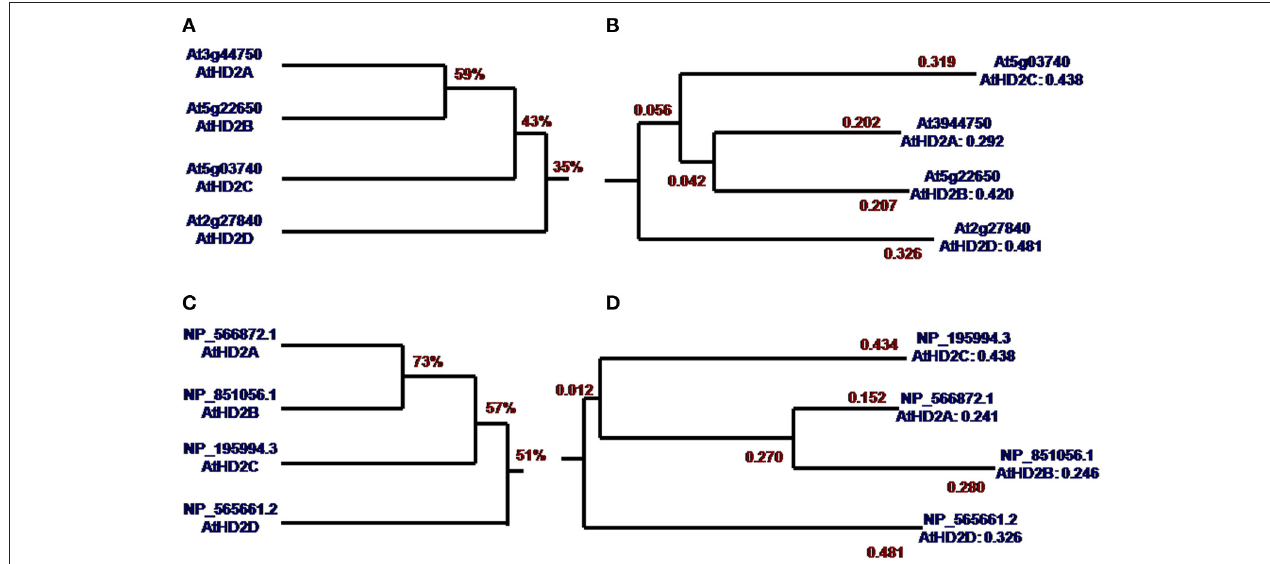
FIGURE 1 | Homology tree and phylogenetic tree of AtHD2 genes and AtHD2 proteins. (A) CDS of AtHD2 gene homology tree. (B) CDS of AtHD2 gene phylogenetic tree. (C) AtHD2 protein homology tree. (D) AtHD2 protein phylogenetic tree.